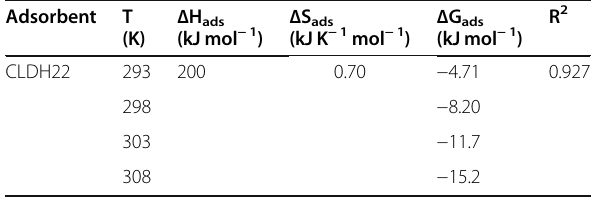
Table 5 The thermodynamic parameters of IDB